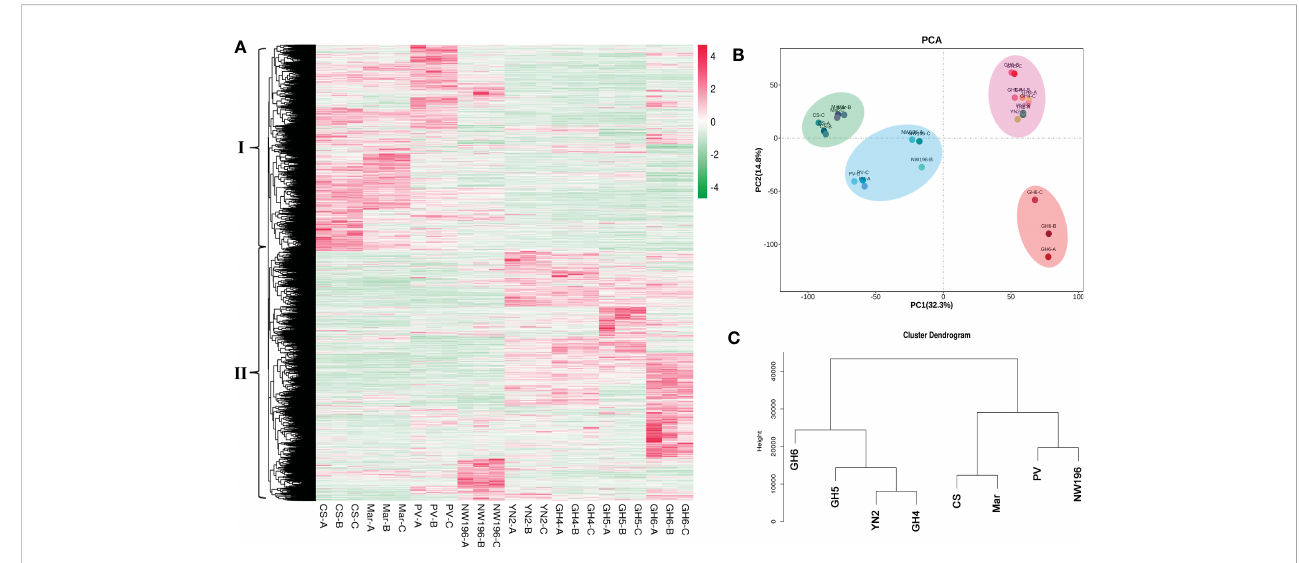
FIGURE 5 Transcriptome data analysis in eight grape varieties. (A) Overview of 30,257 genes in eight grape varieties containing biological duplications. (B) Principal component analysis (PCA). (C) Cluster dendrogram of transcriptome data from grape